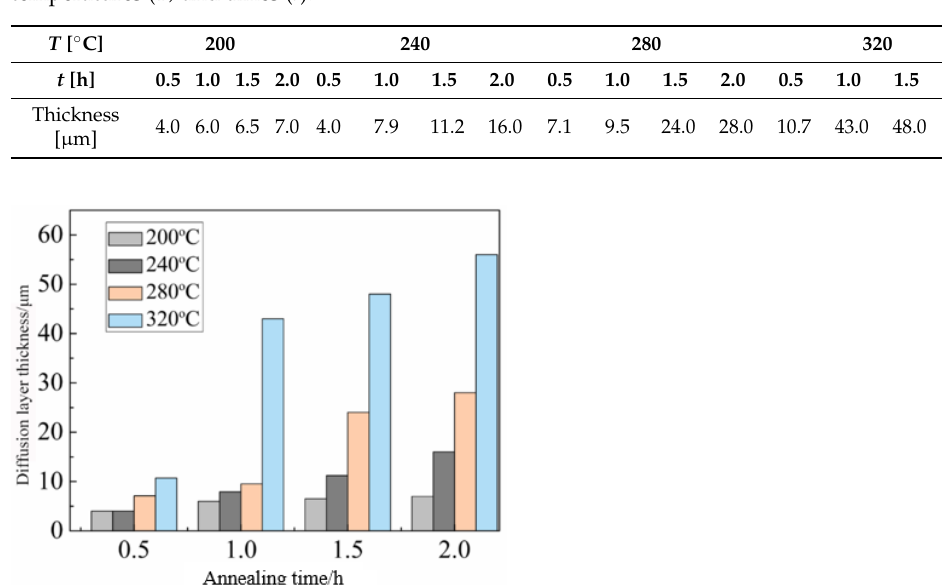
Figure 9. Grain distribution diagram of Al side and Zn side for rolling state and 280 °C × 2 h.